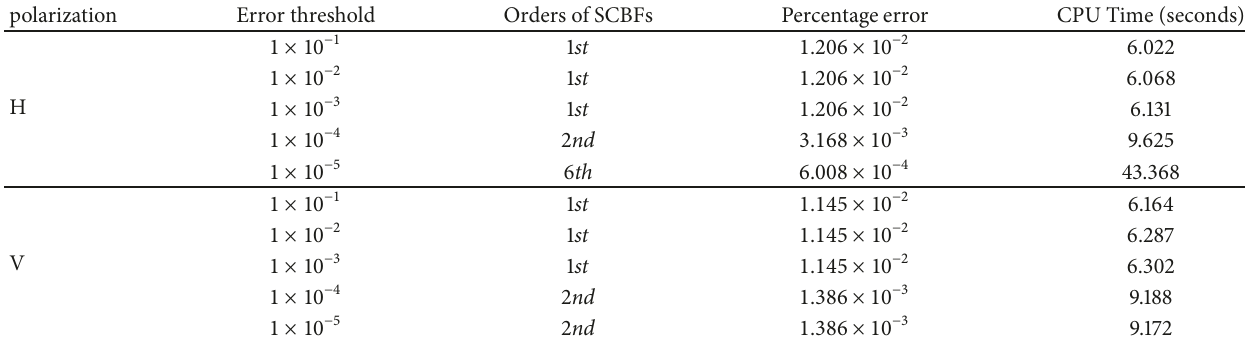
Table 2: The results of the AMCBFM with different error